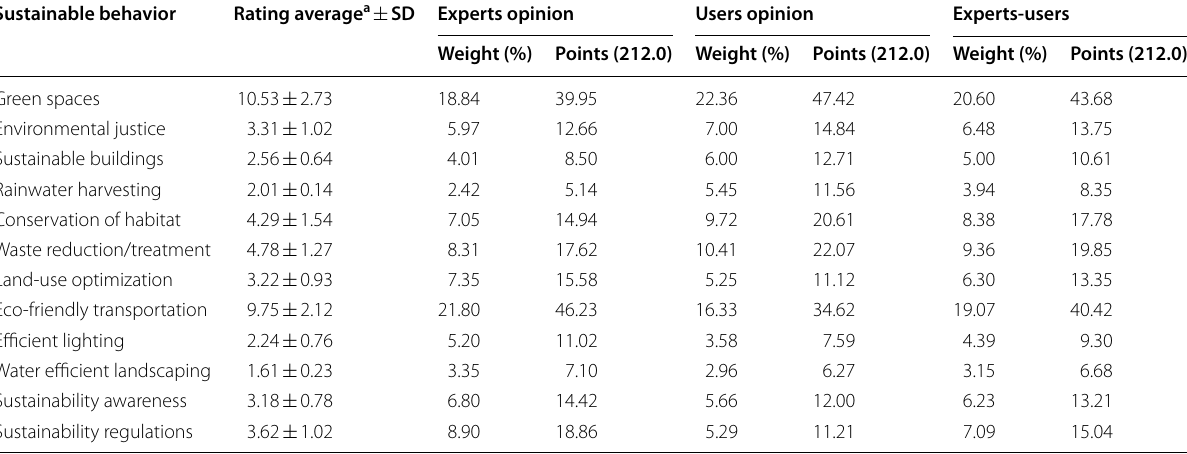
Table 7 Rating and distributed weight of factors in the sustainable behavior category